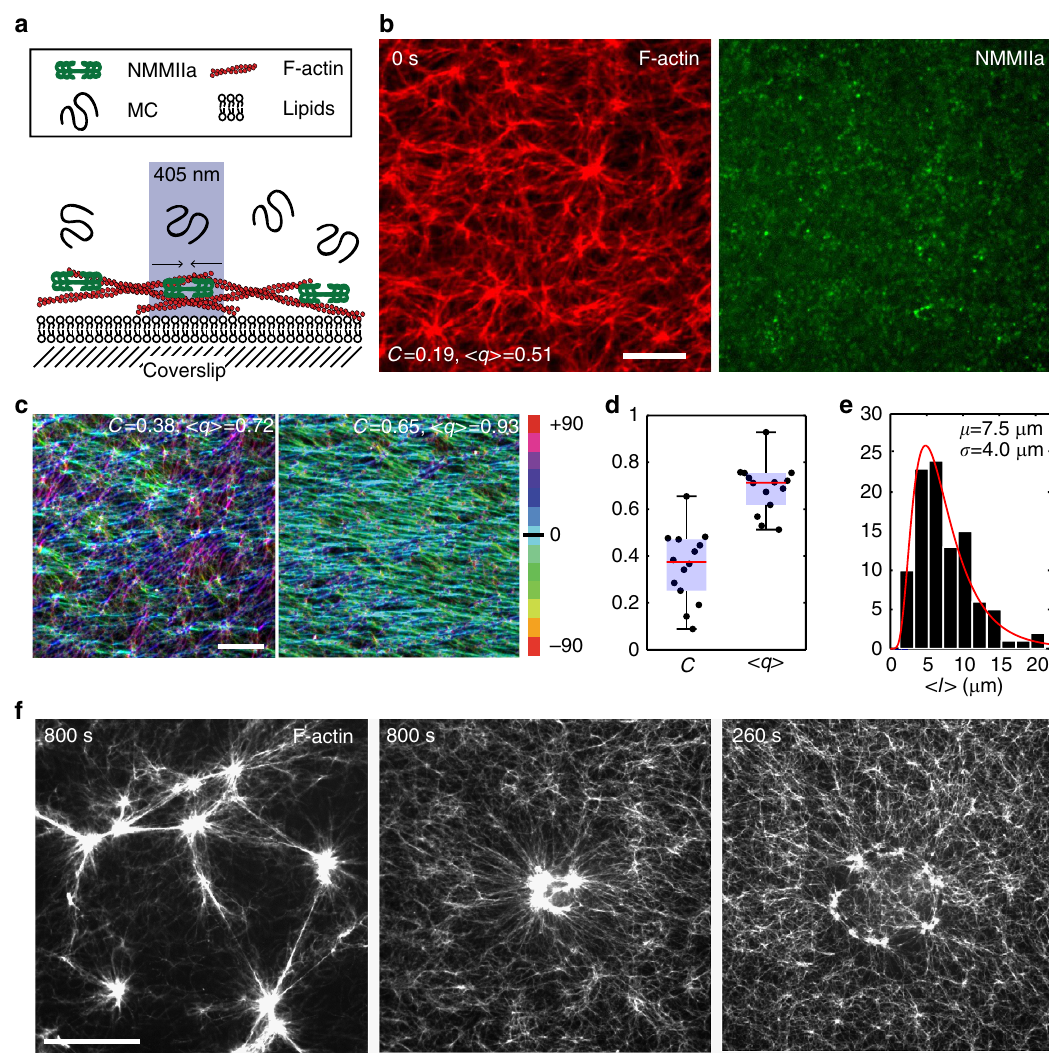
Figure 1 | Blebbistatin inactivation promotes spatiotemporal control of myosin motor activity and F-actin network contractility. ( a ) Stabilized F-actin (red), crowded onto a lipid bilayer by methylcellulose (MC), is decorated with myosin (green), which is inhibited by blebbistatin. Light (405nm) activates myosin activity (arrows). ( b ) Images of actin (left), non-muscle myosin II (right) embedded in 20 m M blebbistatin. Scale bar, 10 m m. ( c ) Fluorescent F-actin in blebbistatin-inhibited actomyosin networks. The colour indicates the orientation of F-actin, in two comparative cases, isotropic (left) and aligned (right). Scale bar, 10 m m. ( d ) Global coherency of F-actin orientation, C , and mean local nematic order parameter, q ( N ¼ 13) (Supplementary Methods). ( e ) Length distribution of F-actin, l , prior to myosin addition ( N ¼ 100); ( f ) contraction of F-actin network where myosin is active over entire field of view (left), blebbistatin is inactivated in a circular central region (middle) and a ring pattern (right). Scale bar, 25 m